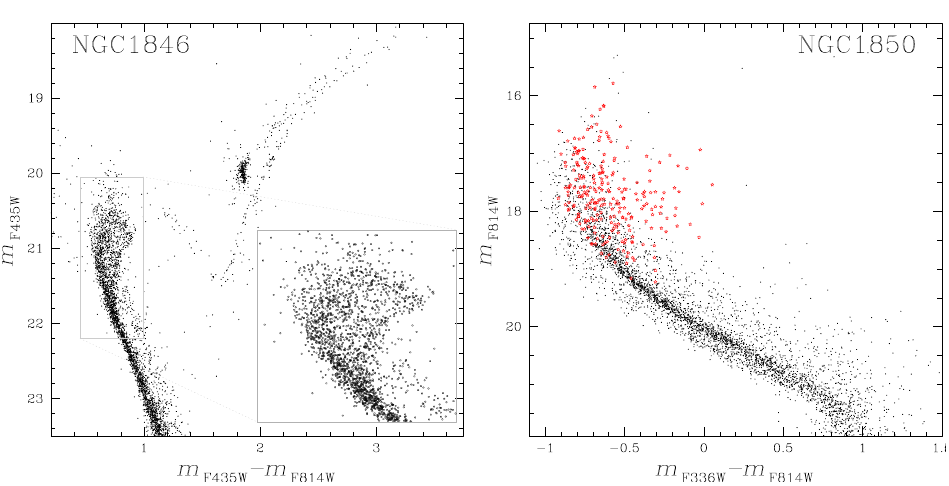
Figure 10. CMDs of the ∼ 1.7-Gyr old LMC cluster NGC1846 ( left ) and of the ∼ 30 Myr old LMC cluster NGC1850 ( right ) [239,240]. The inset in the left panel shows a zoom of the CMD region around the eMSTO of NGC1846, while the Be stars of NGC1850 are marked with red symbols. In addition to the eMSTOs and the split MSs, young clusters have shown distinctive features in their